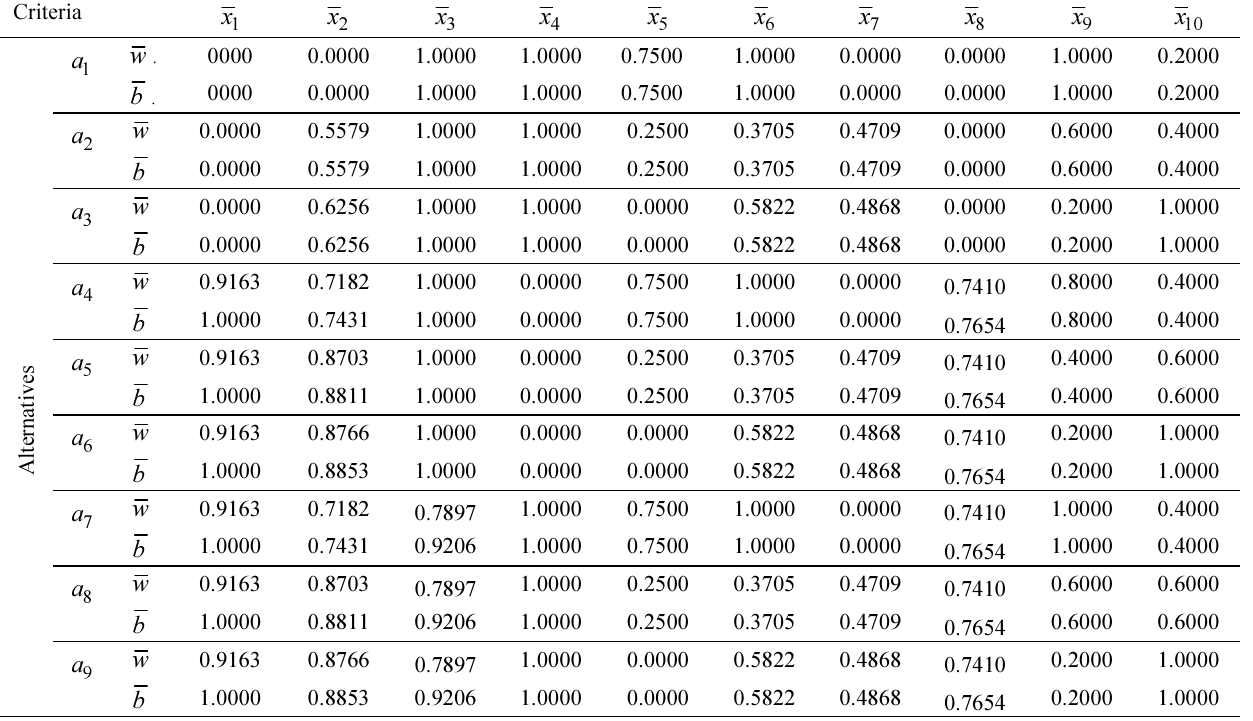
Table 3. Normalised decision-making matrix